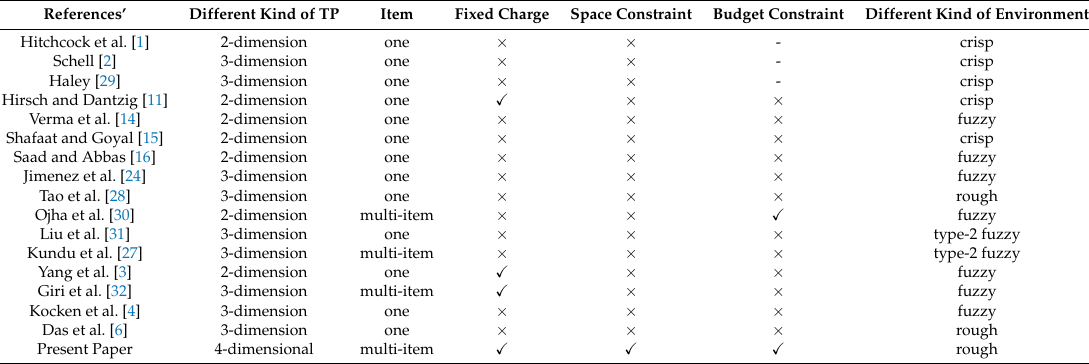
Table 1. Year wise investigations of TP and